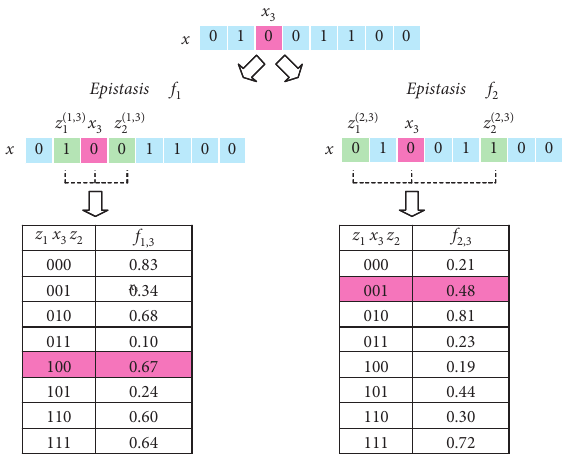
Figure 7: Epistatic interactions